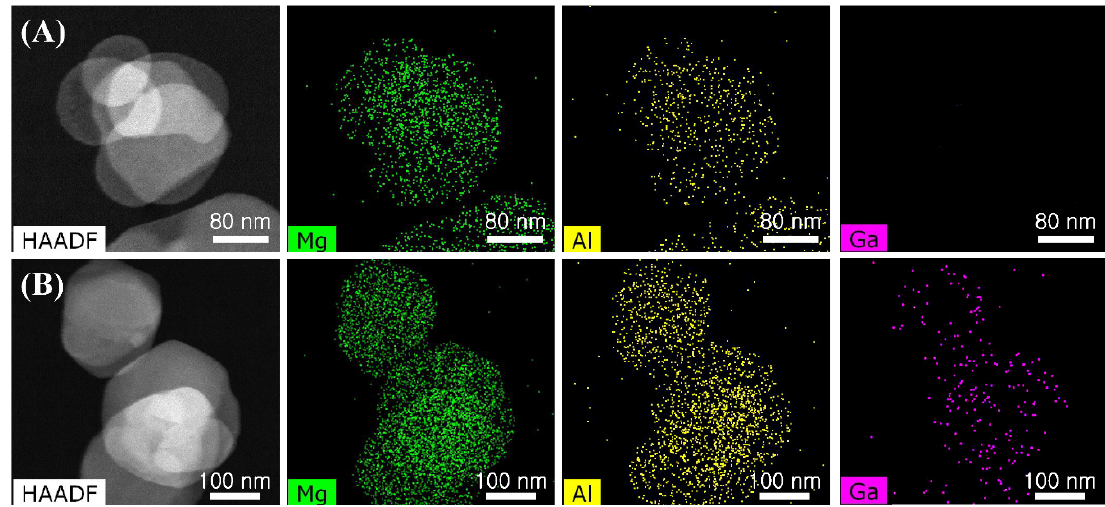
Figure 4. High-angle annular dark-field (HAADF) and element mapping images from transmission electron microscope on ( A ) parent MgAl-LDH and ( B )